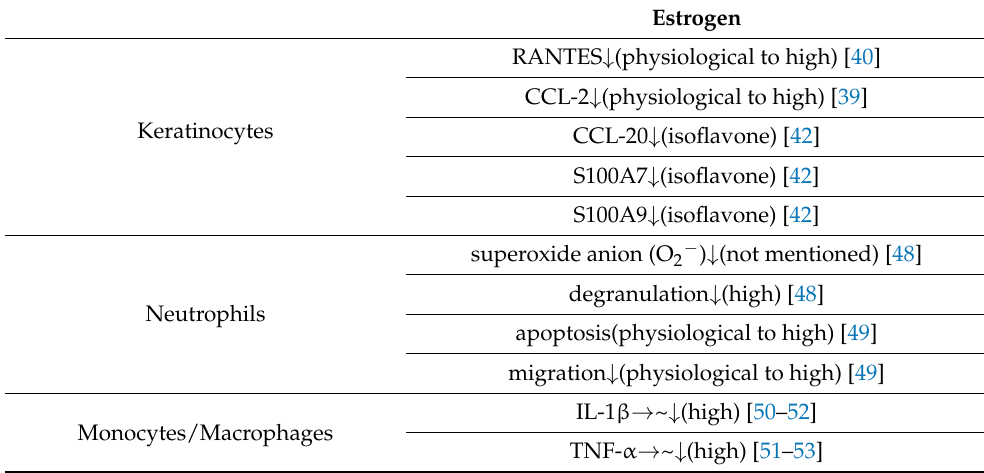
Table 2. In vitro studies regarding the effects of estrogen on immune cell functions related to psori- atic